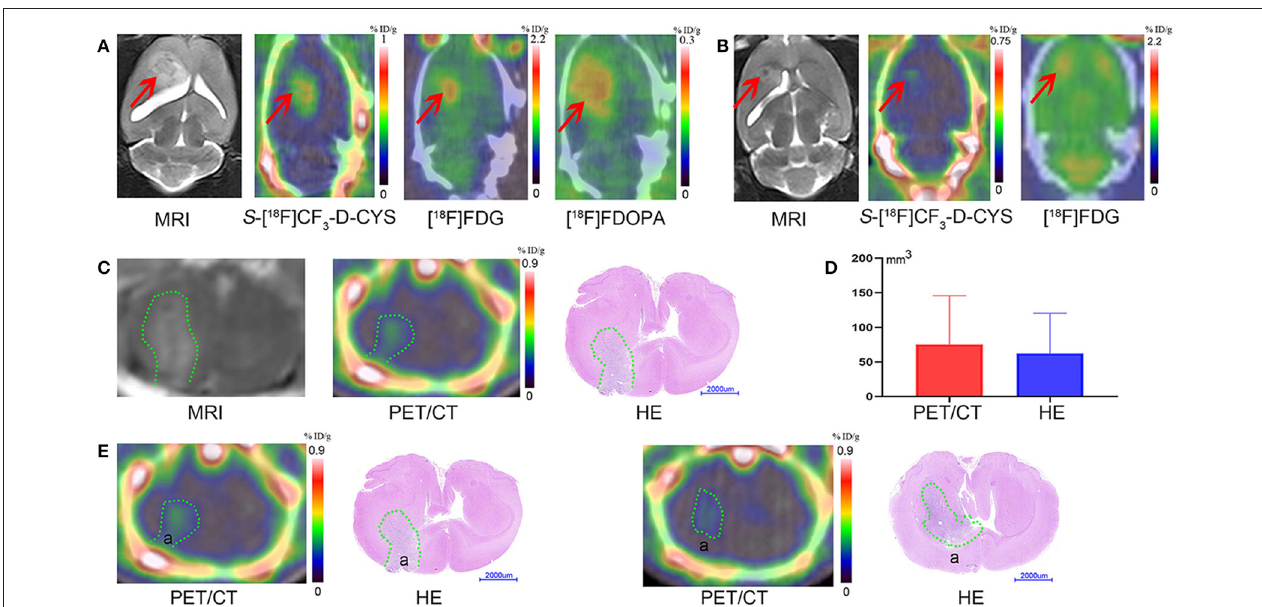
FIGURE 4 | (A) The representative coronal images of the same rat model bearing orthotopic C6 glioma 3 weeks after xenografts with MR imaging, S- [ 18 F]CF 3 -D-CYS PET imaging, [ 18 F]FDG PET imaging, and [ 18 F]FDOPA PET imaging (from left to right) (right arrows: tumors). (B) The representative coronal images of the same model rat bearing orthotopic C6 glioma 1 week after xenografts with MR imaging, S- [ 18 F]CF 3 -D-CYS PET imaging, and [ 18 F]FDG PET imaging (from left to right). Compared with MRI, the tumor with S- [ 18 F]CF 3 -D-CYS PET imaging had a clear tumor boundary (red arrows: tumors). (C) Representative MRI images, S- [ 18 F]CF 3 -D-CYS PET images, and whole-brain HE images on the parallel brain slices of the same rat model. (D) Comparison of the tumoral volume measured from S- [ 18 F]CF 3 -D-CYS PET images and histopathology, showing that there was no significant difference (green curves: tumors). (E) Two successive slides of PET scan images and corresponding HE images. There was tumor infiltration in area a in the left images, while there was no tumor infiltration in area a in the right